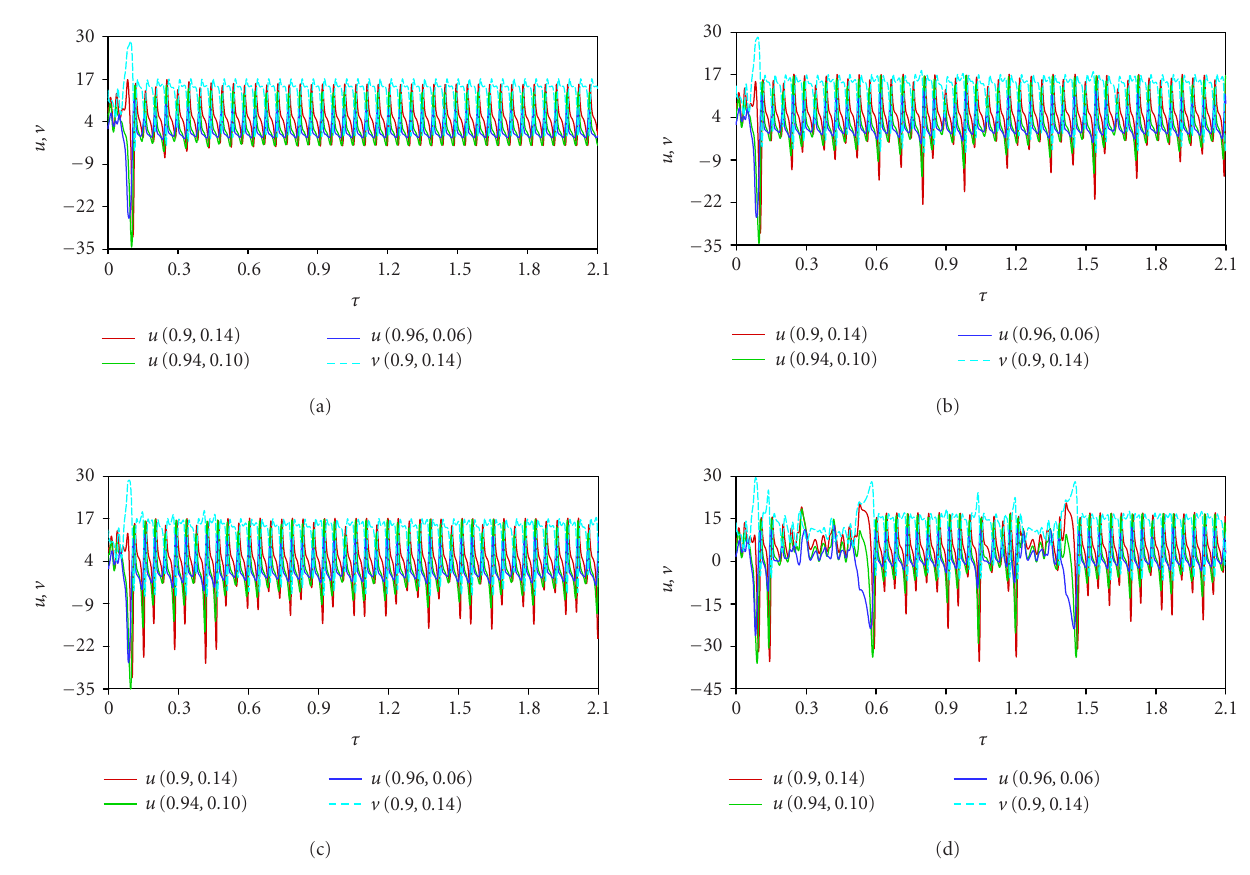
Figure 11: Dynamic responses of the solution to finite random disturbances: subharmonic-bifurcation-driven oscillation ( σ = 0 . 02, Pr = 0 . 7, Dk = 300, and L 1 = 28); (a) L 2 = − 10 . 20 on AS 1 s , (b) L 2 = − 10 . 25 on AS 1 s , (c) L 2 = − 10 . 30 on AS 1 s , and (d) L 2 = − 10 . 35 on AS 1 s